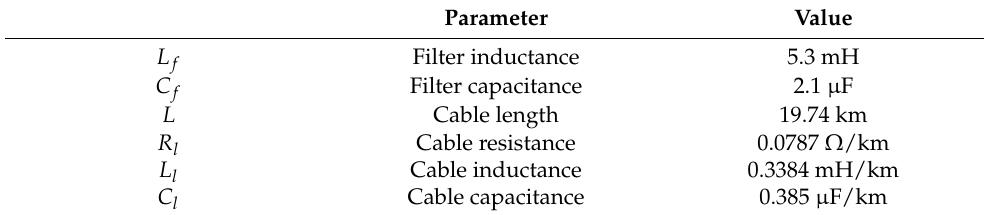
Table 2. Filter and Line parameters.